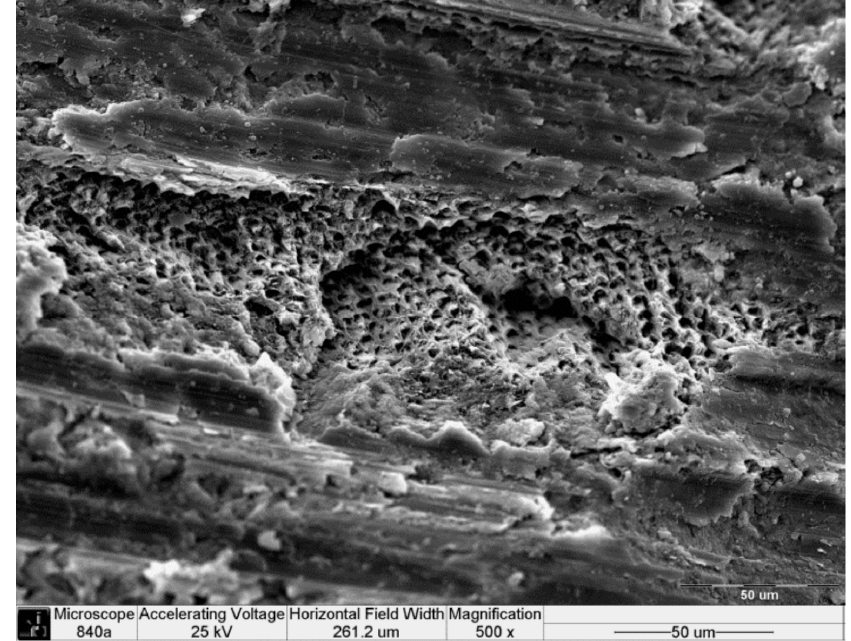
Figure 2. Scanning electron microscopy (SEM) micrograph (500×) of the dentin surface after preparation with a diamond bur. The longitudinal striations of the bur, open dentinal tubules and remnants of the smear layer are evident. Int. J. Mol. Sci. 2016 , 17 , 426